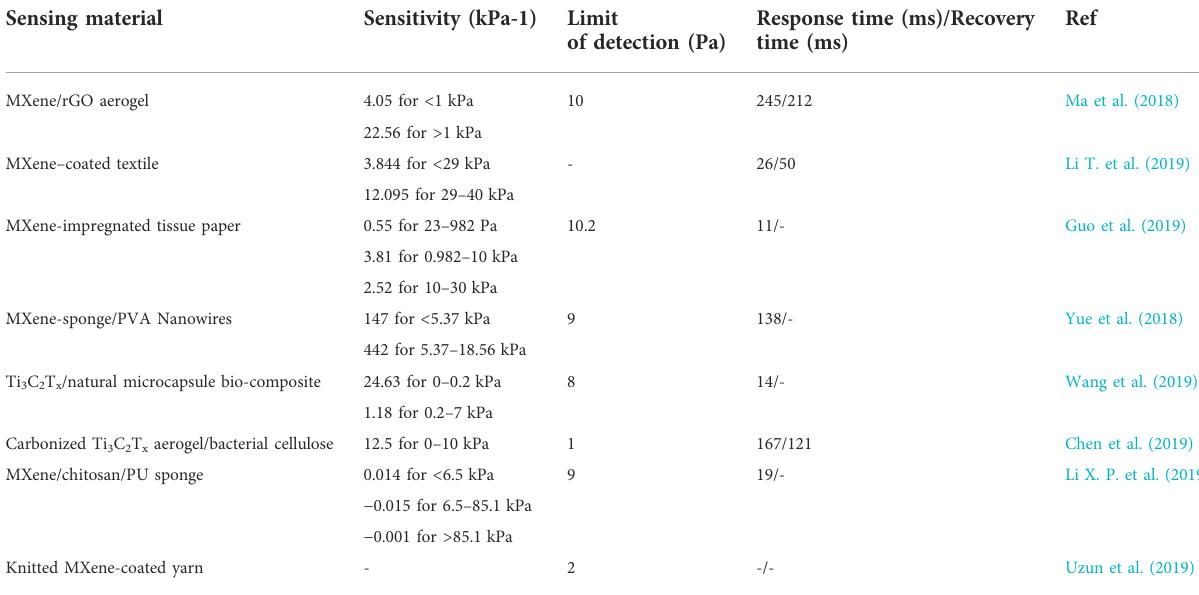
TABLE 1 Summary of MXene-based pressure